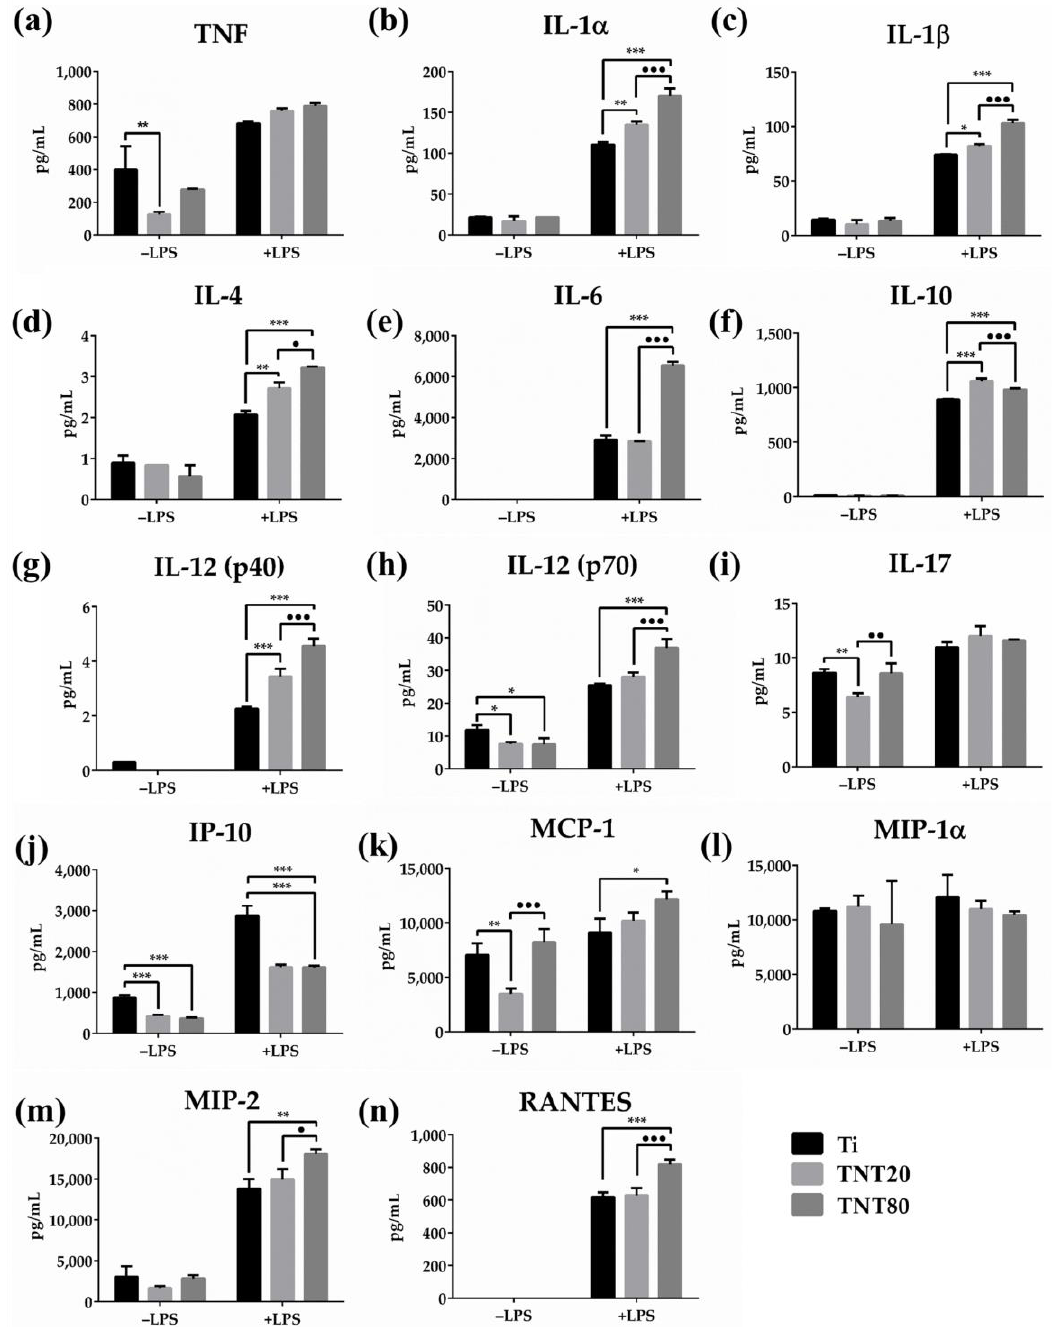
Figure 7. Extracellular cytokine/chemokine levels determined by Luminex-based multiplex assay, analyzed after 48 h of direct contact with the tested materials, both in standard and pro-inflammatory conditions (treatment with 100 ng mL −1 LPS) for ( a ) TNF, ( b ) IL-1α, ( c ) IL-1β, ( d ) IL-4, ( e ) IL-6, ( f ) IL-10, ( g ) IL-12(p40), ( h ) IL-12(p70), ( i ) IL-17, ( j ) IP-10, ( k ) MCP-1, ( l ) MIP-1α, ( m ) MIP-2, ( n ) RANTES. The highest level of cytokines/chemokines was secreted in pro-inflammatory conditions by the RAW 264.7 cells grown onto the surface of the TNTs supports, while in the absence of the pro-inflammatory agent (−LPS), very low amounts of cytokines were noticed in the cell growth media. Results are expressed as means ± SD ( n = 3, * p < 0.05, ** p < 0.01, *** p < 0.001 vs. Ti; • p < 0.05, •• p < 0.01, ••• p < 0.001 vs. TNT20).